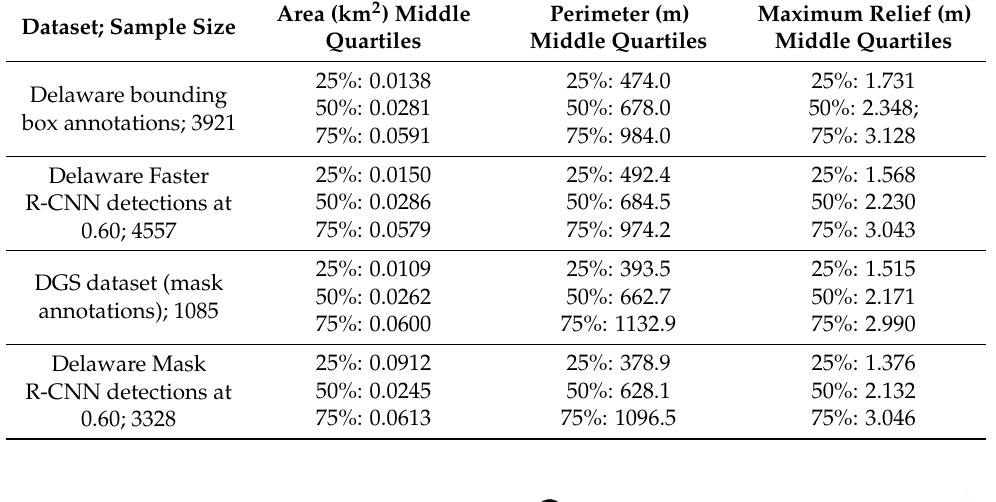
Table 2. Area, perimeter, and max. relief middle quartiles for annotations and detections from Delaware.